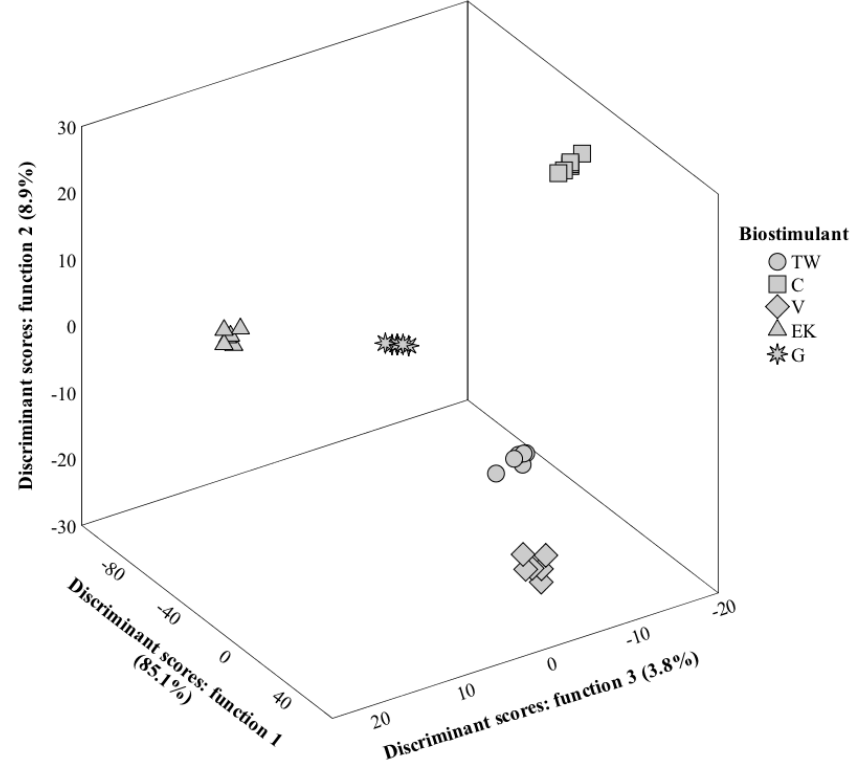
Figure 2. Canonical discriminant functions coefficients defined from the evaluated parameters plotted to show the effect of biostimulants treatments on Phaseolus vulgaris green pods of the first harvest under different irrigation regimes (normal irrigation and water stress).